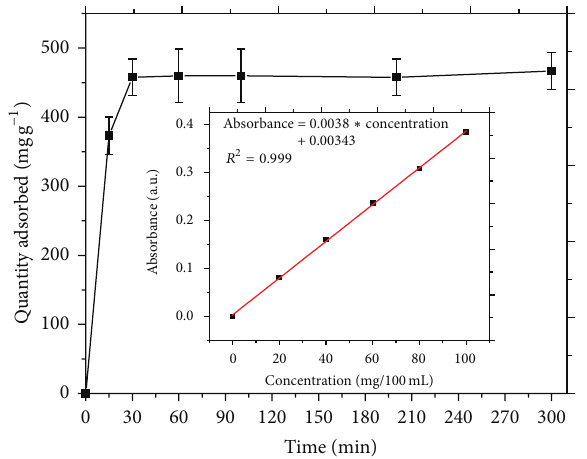
Figure 3: Time dependence of urea adsorption by MMT NP. Inset: calibration curve for urea